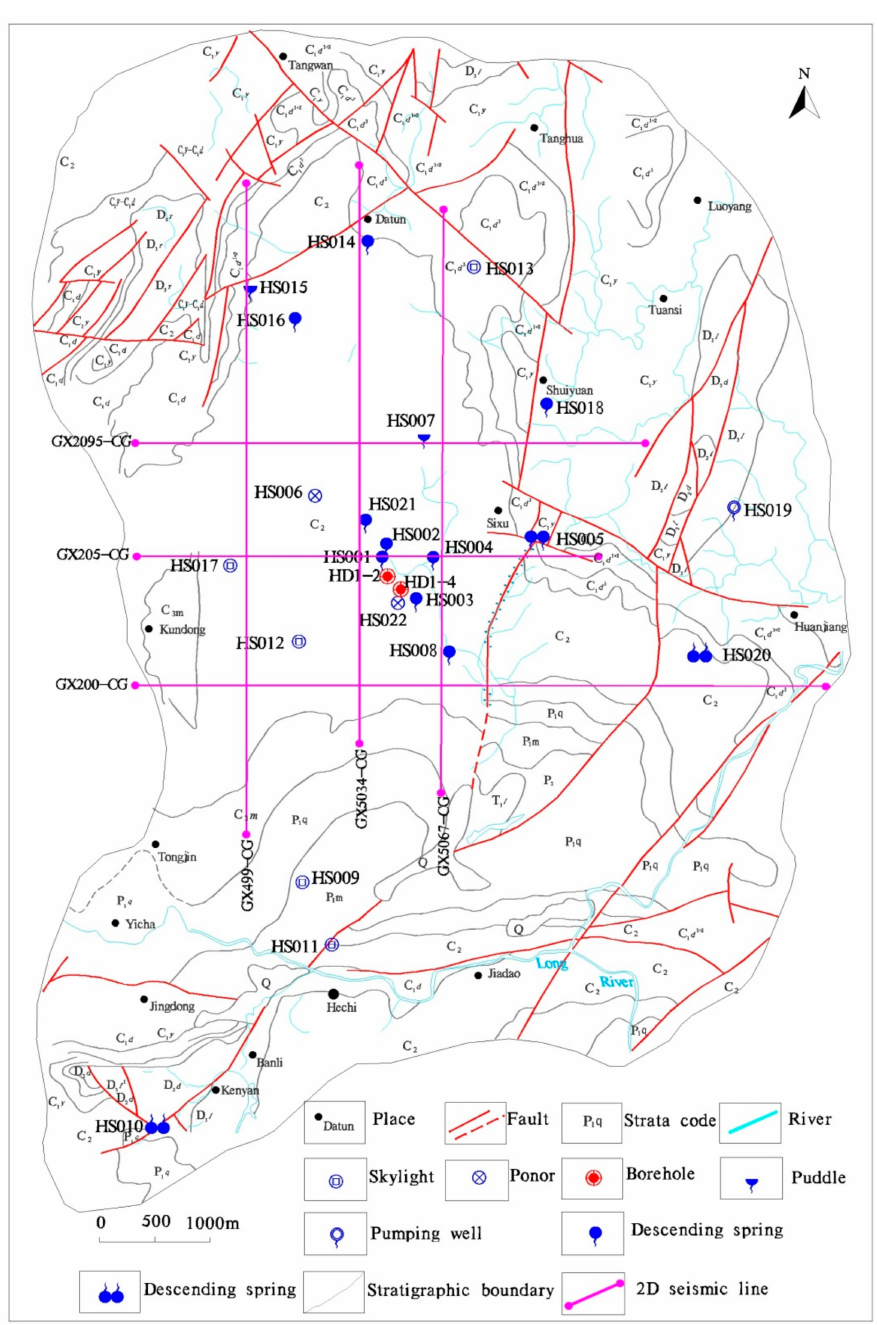
Figure 4. Distribution map of karst groundwater sampling places in Huanjiang